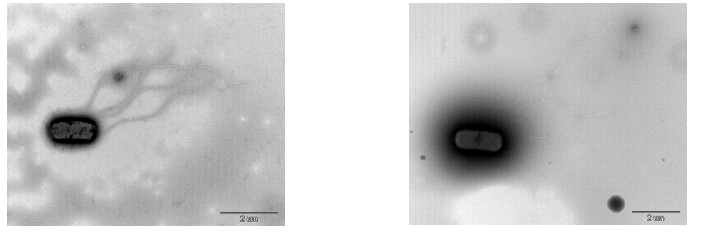
Fig. 1. Escherichia coli JCM1649 T Fig. 2. Bacillus subtilis JCM1465 T